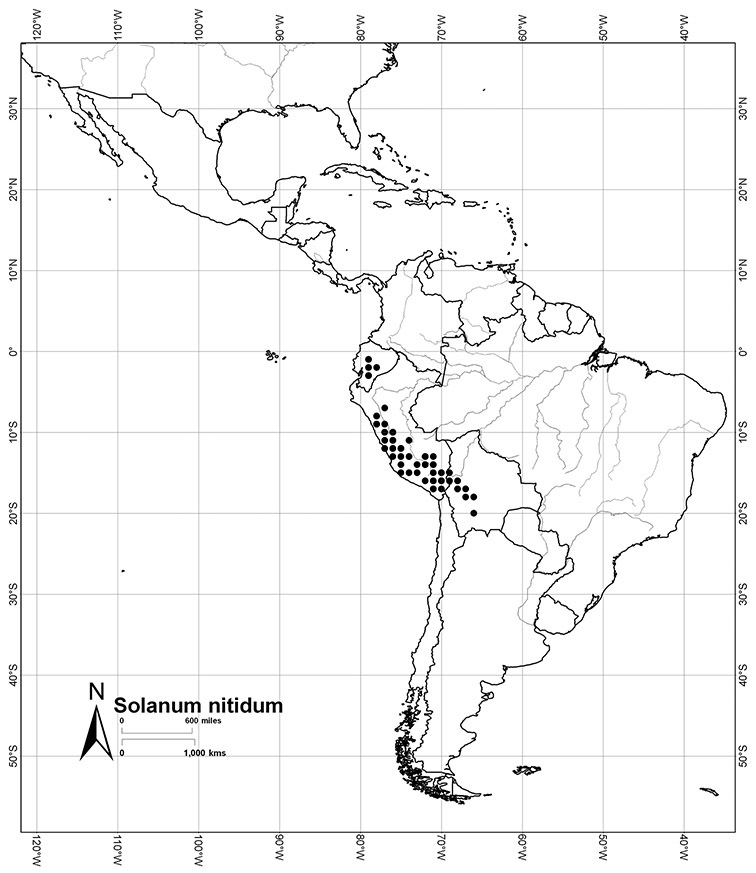
Distribution of Solanum nitidum Ruiz & Pav.